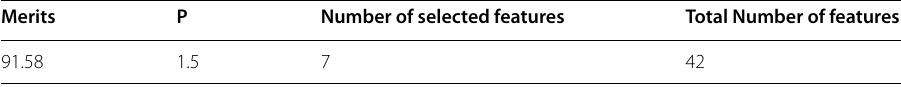
Table 12 Number of selected features by proposed method on NSL dataset Merits